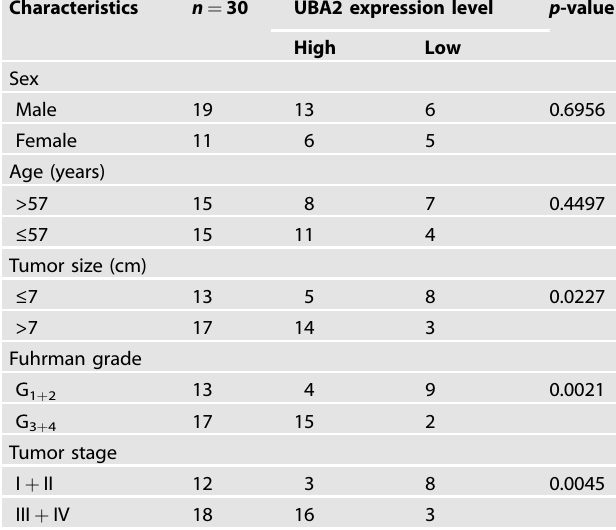
Table 1. Correlation of UBA2 protein levels with demographic and clinicopathological characteristics of patients with clear cell renal cell carcinoma.